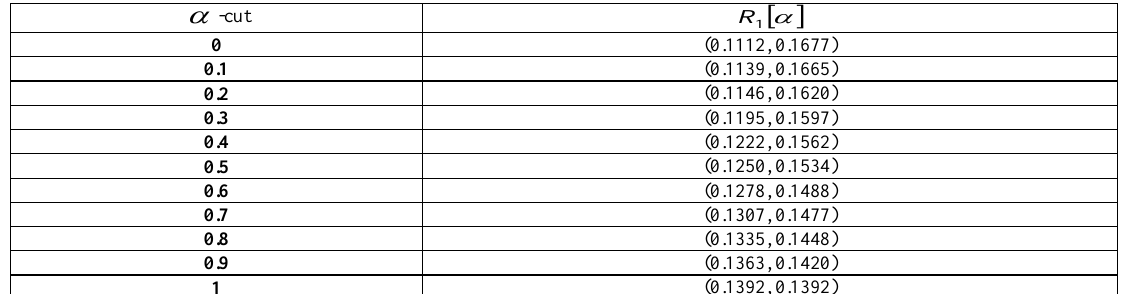
Table 3. Reliability of the linear system after aggregation